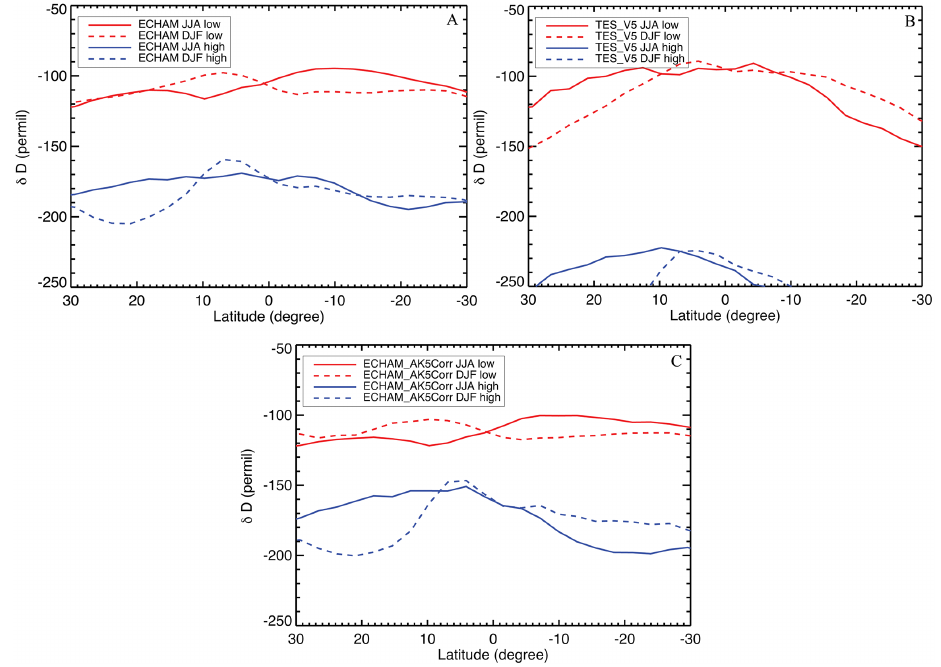
Figure 6. Latitudinal profiles between 30 ◦ N and 30 ◦ S in northern summer (JJA, solid lines) and northern winter (DJF, dashed lines) of ECHAM weighted averaged from 900 to 680hPa and from 618 to 425hPa (a) , of TES V5 from 900 to 680hPa and from 618 to 425 hPa (b) , and of ECHAM AK5Corr from 900 to 680hPa and from 618 to 425hPa (c)